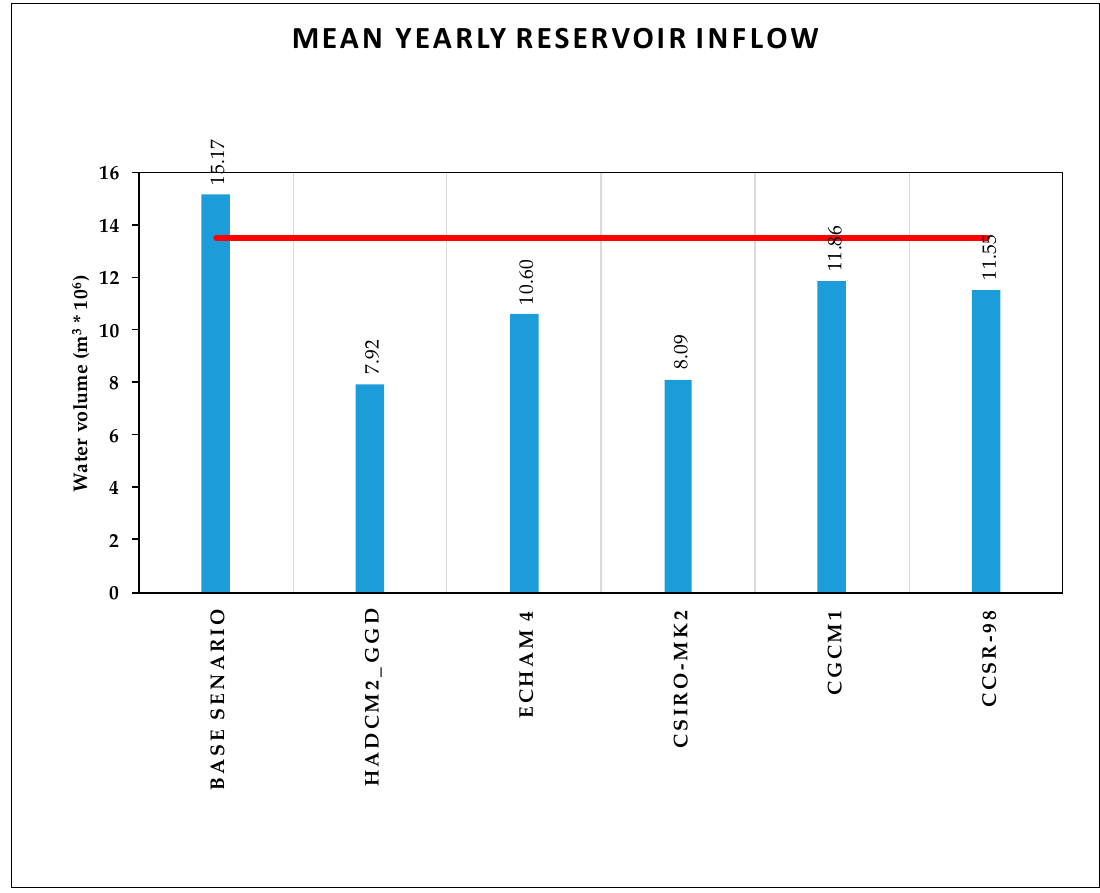
Figure 6. Annual average of input water volume into the reservoir for the base scenario and for the future based on climate change scenarios.